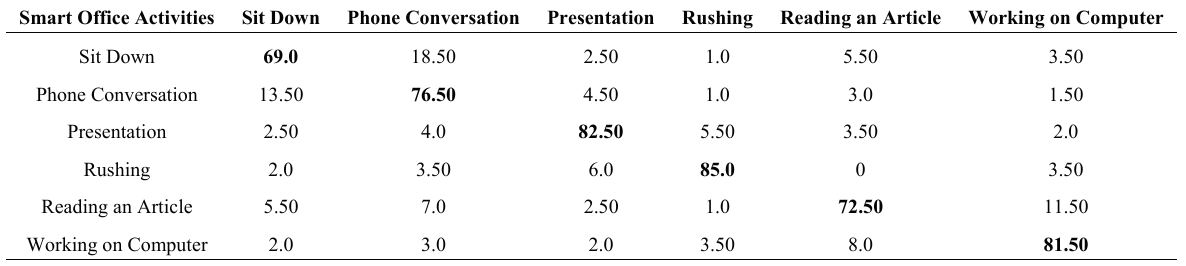
Table 6. Confusion matrix based on recognition results of smart office activities using PC features of depth silhouettes.